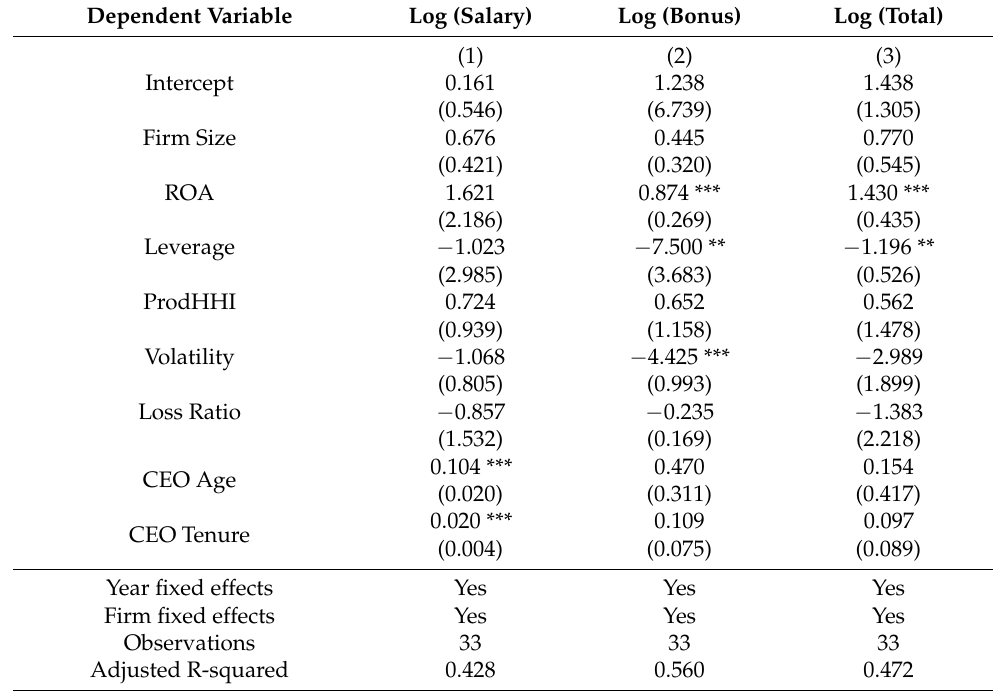
Table 3. Determinants of CEO Compensation (Korean Non-life Insurance Firms) using the Bootstrap